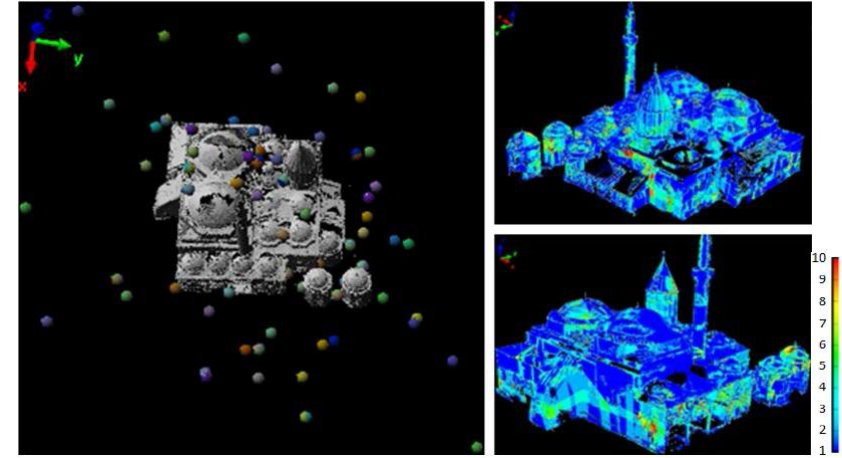
Figure 5. The outside of the museum was measured by laser scanner from 110 stations. Some details were scanned many times with overlapped measurements. The color legend on the right shows the repeated measurements (for example, red areas were measured10 times).